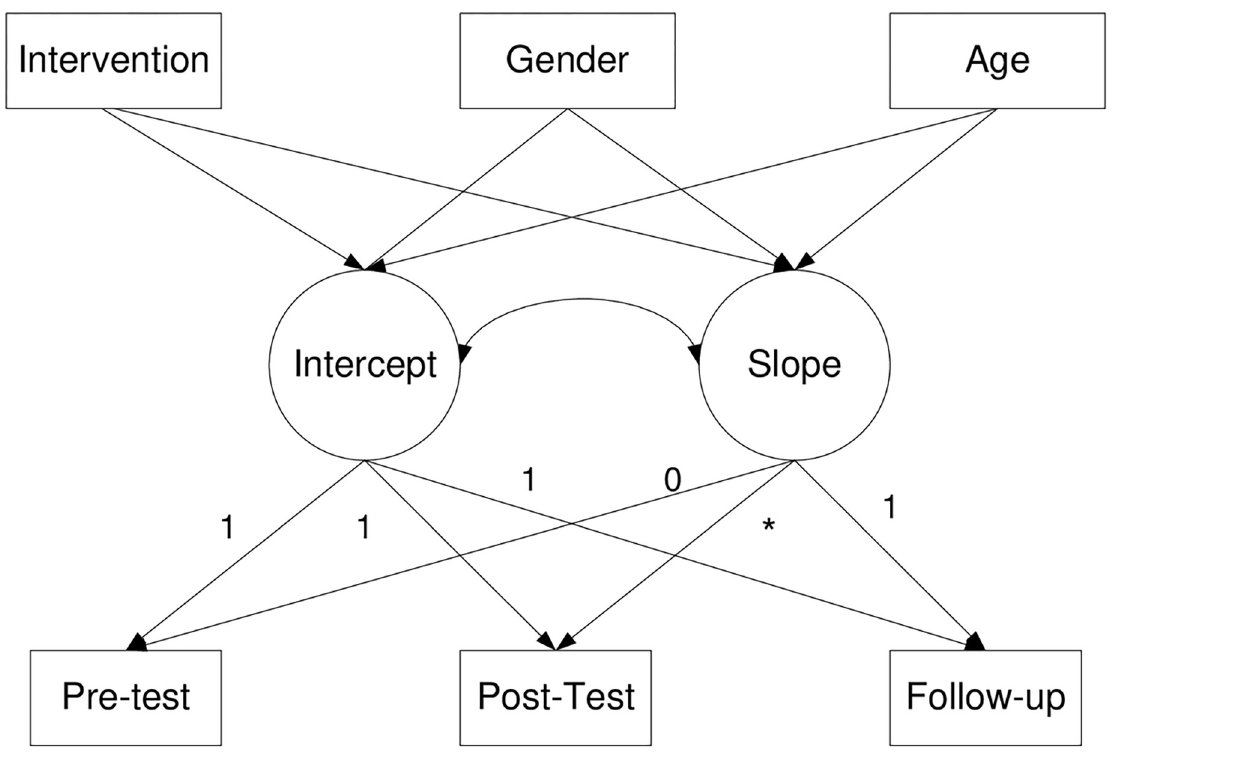
Fig 4. The effect of the Hero intervention program on the intercept and slope of positive emotions and prosociality (toward strangers, friends and family) controlling for age and gender.